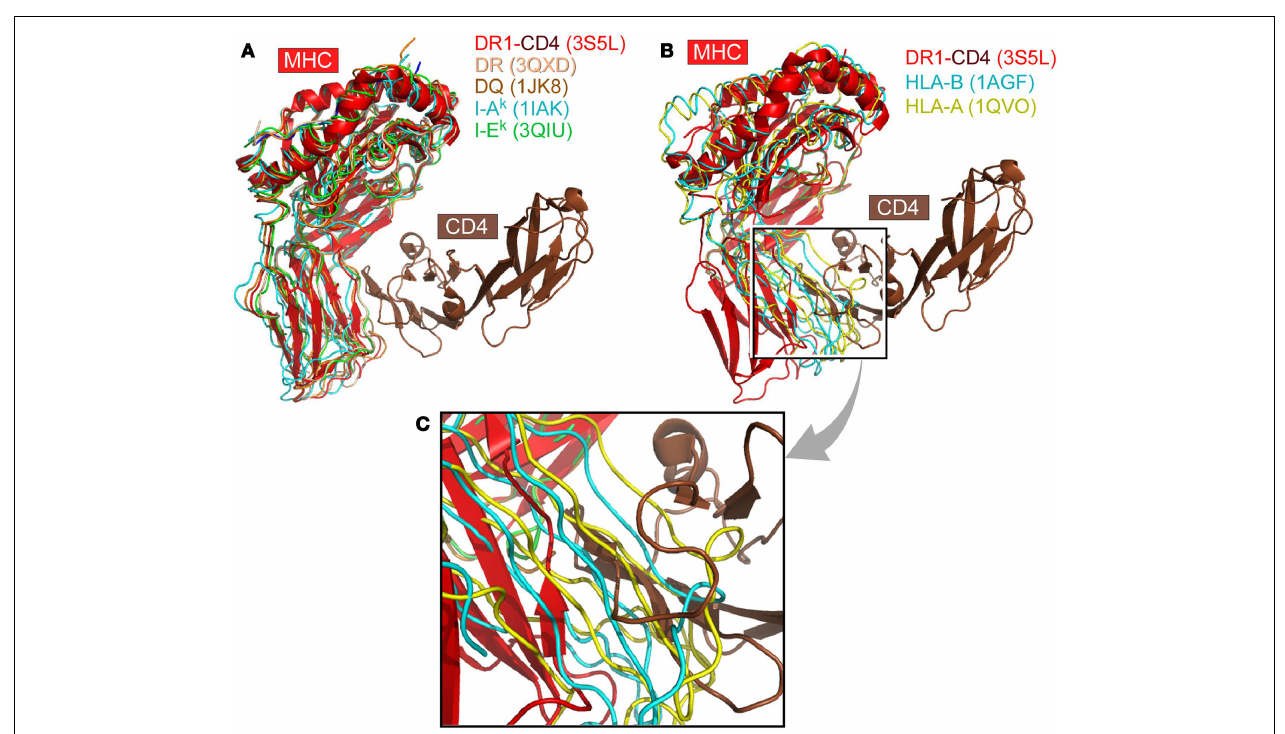
onto the DR1-CD4 complex structure. Here the β 2M domain of MHCI was overlaid on the α 2 domain of DR1 molecule.These two selected MHCI molecules have the largest (1AGF, in blue) and smallest (1QVO, in yellow) opening angle, respectively, between the two membrane-proximal domains, α 3 and β 2M. Compared with the MHCII DR1-CD4 complex, they do not have a sufficiently large opening angle to accommodate CD4. (C) Close-up of (B)